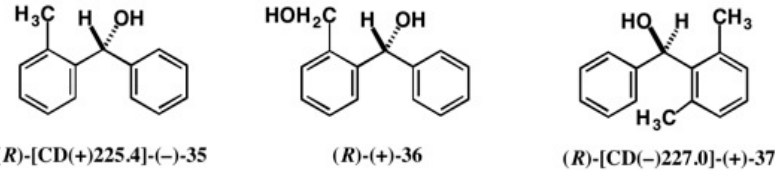
Figure 23. ACs of chiral o -substituted diphenylmethanols.